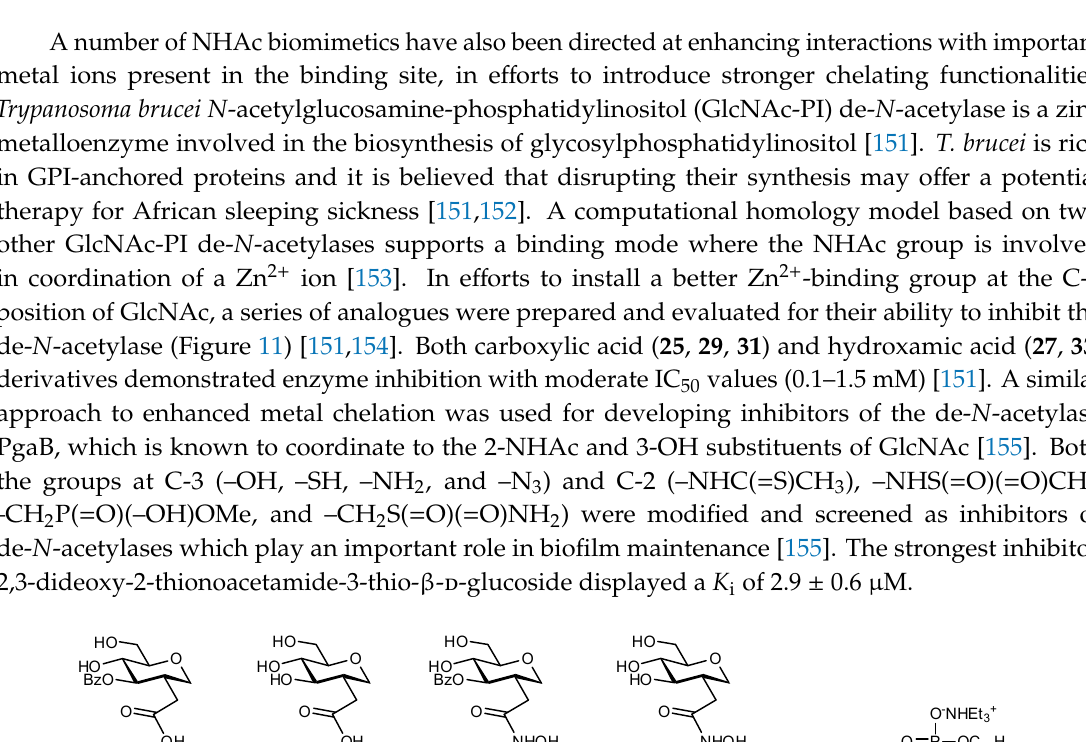
Figure 10. 2-Deoxy-2- C -alkylglucosides of myo -inositol were synthesized as inhibitors of a Mycobacterium smegmatis de- N -acetylase [150] .